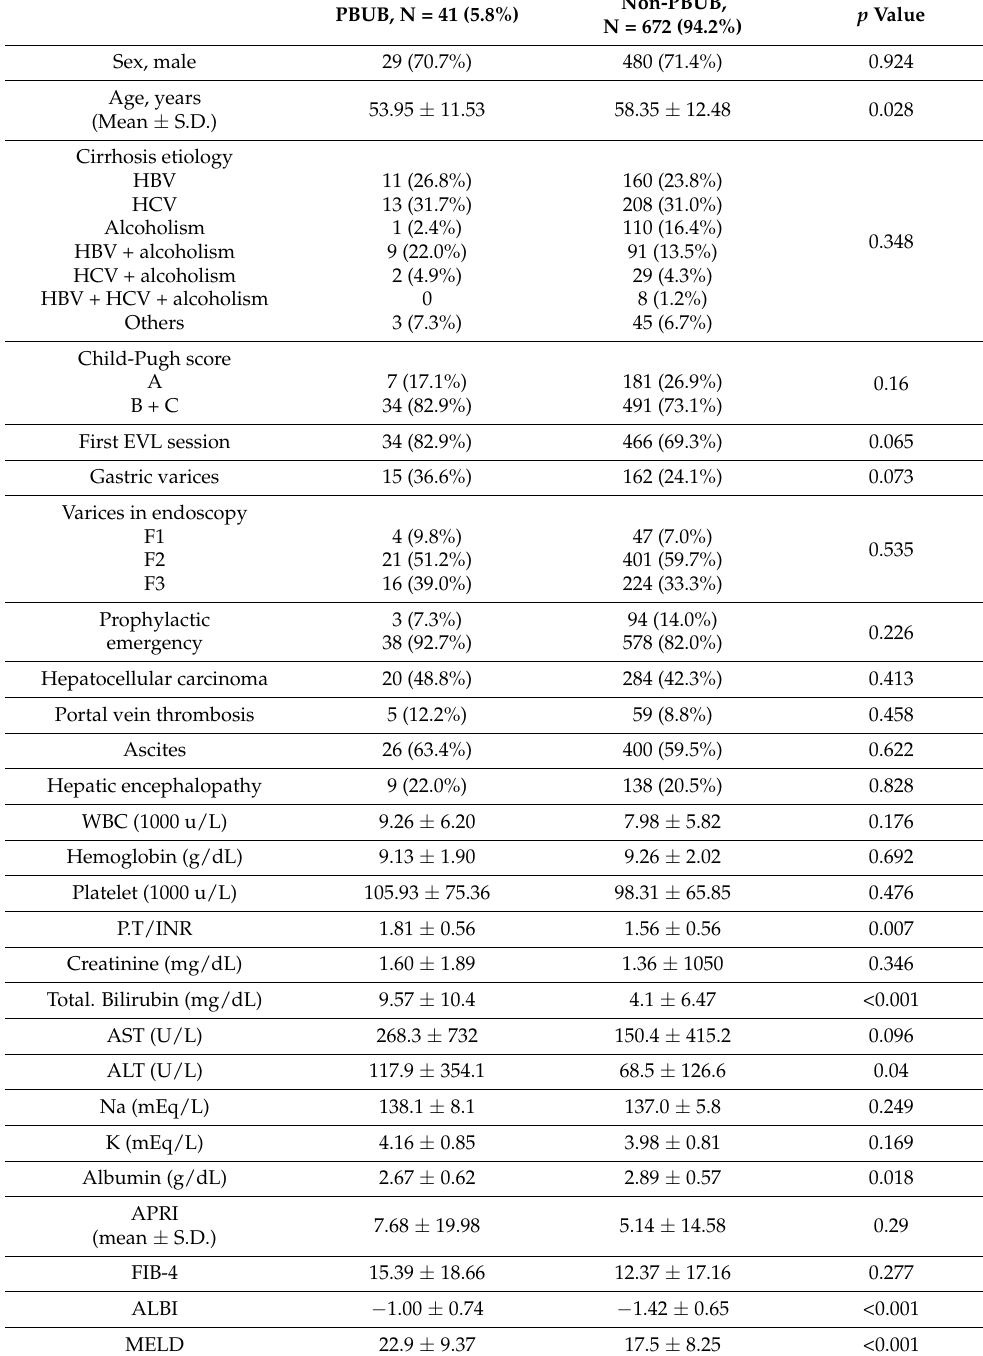
Table 1. Baseline demographic and clinical characteristics of the patients in PBUB and non-PBUB